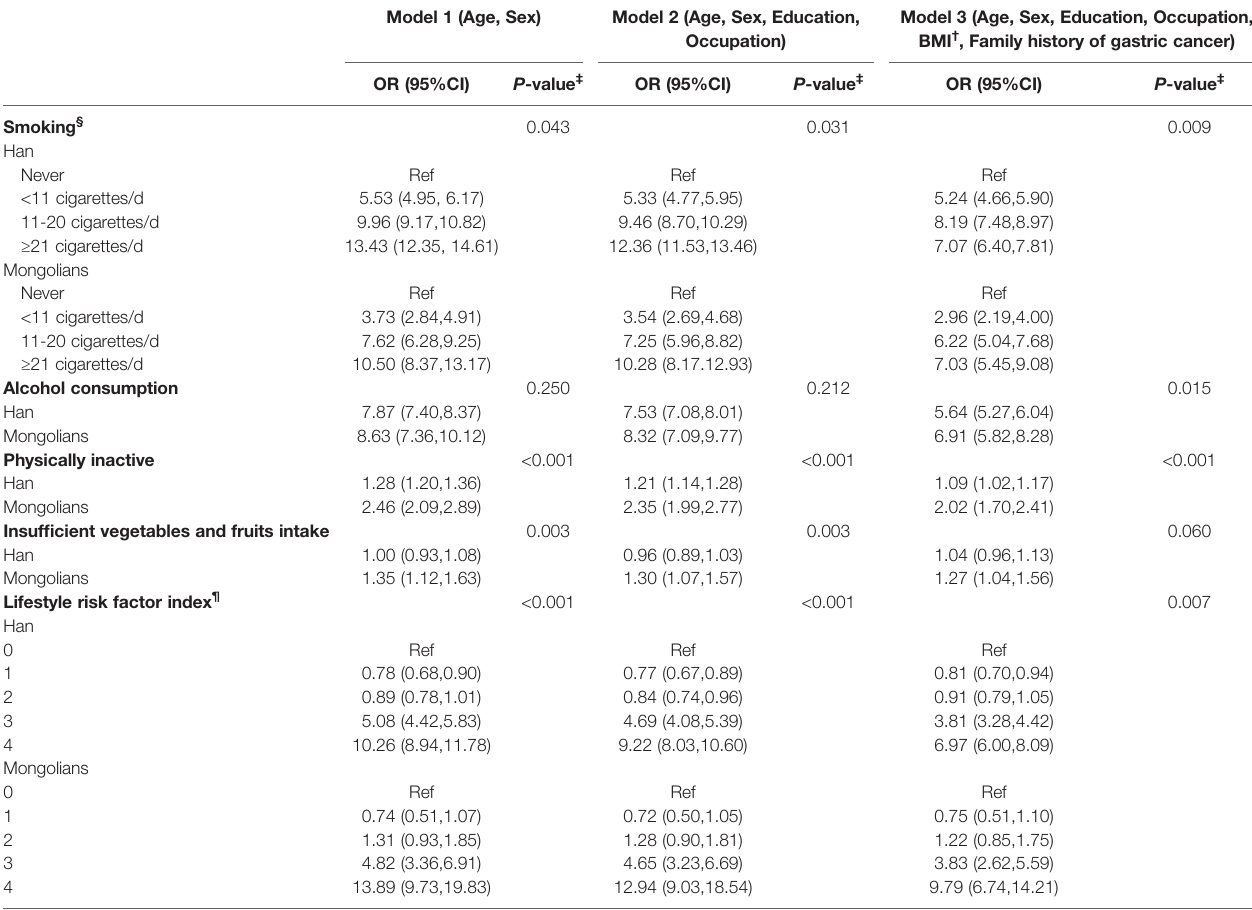
TABLE 3 | Multivariable-adjusted ORs(95%CIs) for GPL by lifestyle factors* grouped by ethnicity. Model 1 (Age, Sex) Model 2 (Age, Sex, Education,